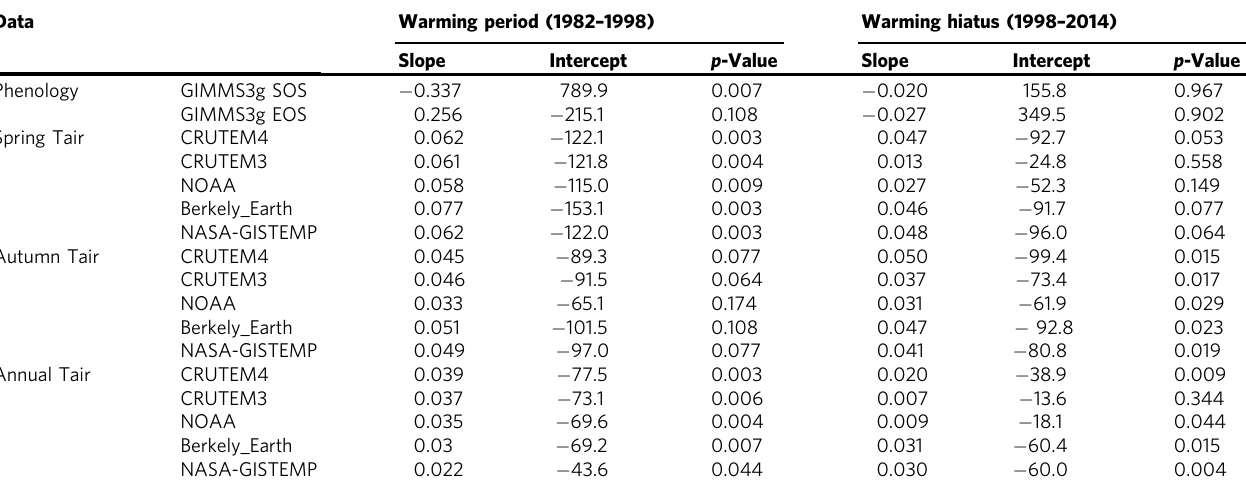
Fig. 1 Phenology and temperature trends in the northern hemisphere (latitude ≥ 30°) from 1982 to 2014. a The trend of SOS estimated from the GIMMS3g NDVI dataset. b The trend of EOS estimated from the GIMMS3g NDVI dataset. c The trends of spring temperature anomalies from CRUTEM3.0, CRUTEM4.6, NOAA, Berkley Earth, and NASA GISTEMP. d The trends of autumn temperature anomalies from CRUTEM3.0, CRUTEM4.6, NOAA, Berkley Earth, and NASA GISTEMP. e The trends of annual temperature anomalies from CRUTEM3.0, CRUTEM4.6, NOAA, Berkley Earth, and NASA GISTEMP. The dashed lines stand for the long-term trend (1982 – 2014) calculated using the Mann – Kendall Tau-b with Sen ’ s method. The light gray background indicates the warming hiatus (1998 – 2012). Mann – Kendall trend test was performed for the periods before 1998 and after 1998, separately. SOS start of growing season, EOS end of growing season, DOY day of year Table 1 Results of Mann – Kendall trend test performed for phenology and temperature for the periods before 1998 and after